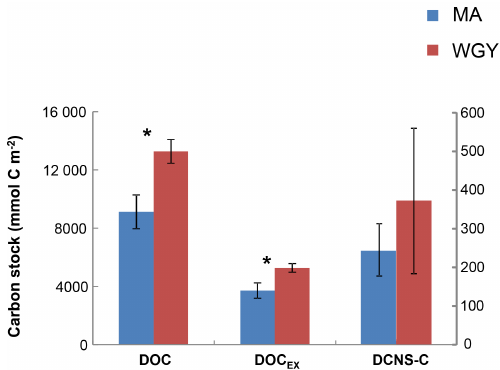
Figure 6. Integrated carbon stocks (mmolCm − 2 ) over the euphotic zone carbon in terms of DOC, DOC EX and DCNS-C (secondary axis). ∗ DOC and DOC SL were statistically different between MA and WGY areas (Mann–Whitney test, p < 0 .